Question: What style of plot is this figure drawn as?
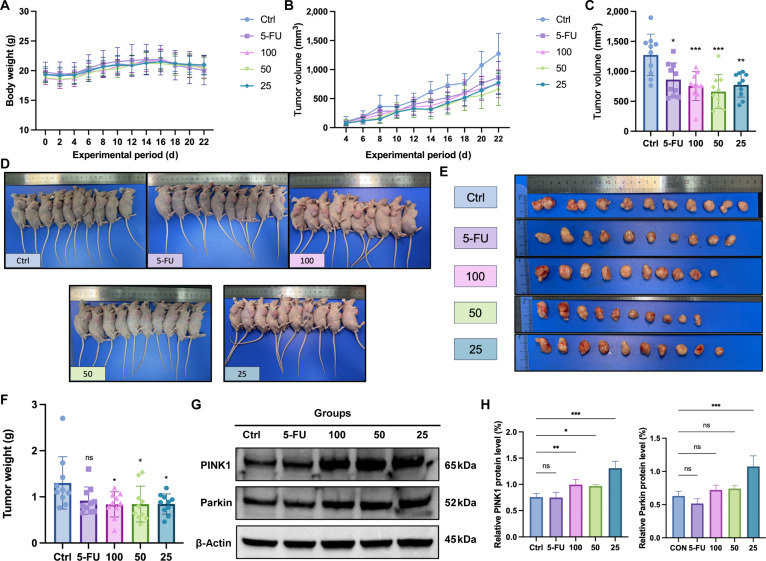
Answer: line